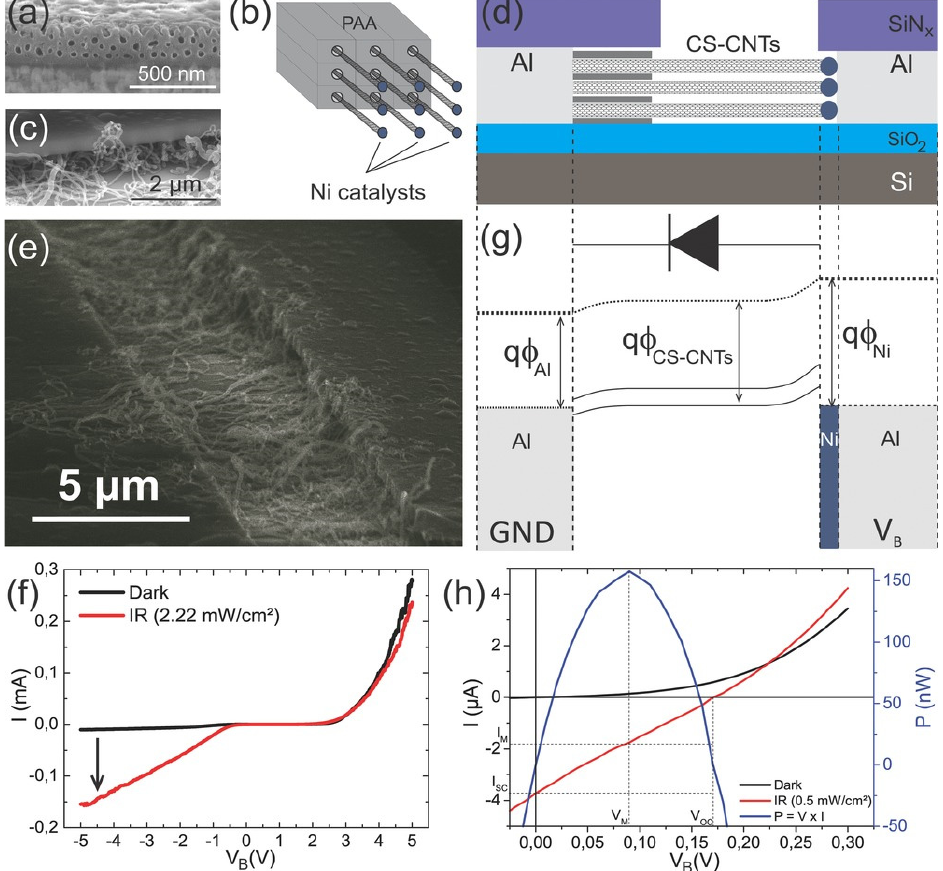
Figure 35. Schematized the geometry of both adopted approaches to engineering Schottky diode devices based on cup-stacked carbon nanotubes arrays grown in lateral-PAA anodized alumina templates asymmetrically contacted. ( a ) SEM image of lateral-PAA without capping layer before the CS-CNTs, ( b ) ketch of CS-CNTs emerging from the pores, ( c ) SEM image of Lateral-PAA with SiNx capping layer after CS-CNTs growth. ( d ) Sketch of CS-CNT Schottky diode. ( e ) SEM image of a channel between the lateral-PAA and aluminum electrode contacted by CS-CNTs. ( f ) Current-voltage curve of the photo-diode device in the dark and under iR illumination. ( g ) Band-diagram of the lateral-PAA/Cs-CNTs device at zero bias. ( h ) Magnified current, bias voltage, and power characteristics around the origin in the dark (black line) and under illumination (red line). Reprinted with permission from Ref. [14]. Copyright © 2023 WILEY-VCH Verlag GmbH & Co. KGaA, Weinheim.